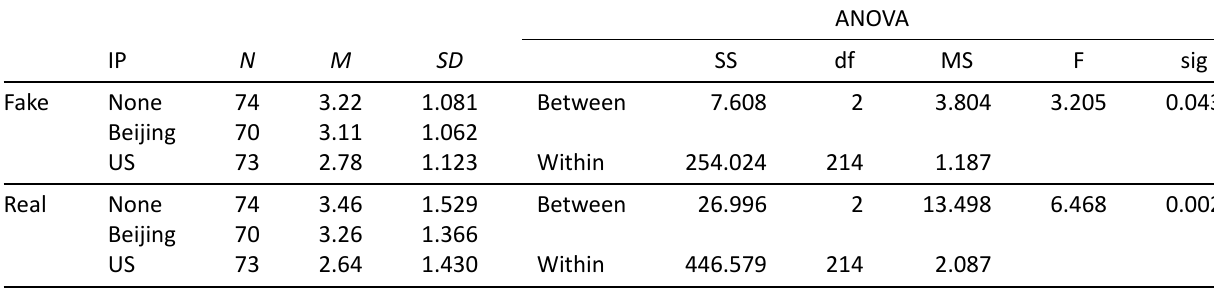
Table 4. ANOVA and description of the effect of different IPs on information judgment.